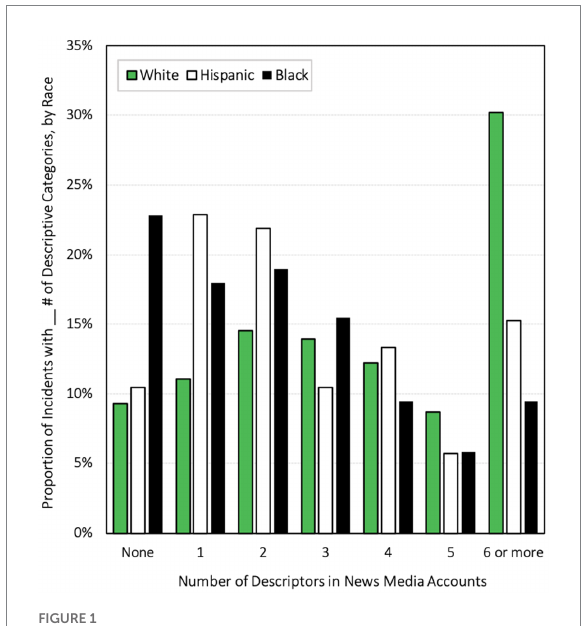
FIGURE 1 Average frequencies of descriptive categories in news media accounts of mass shootings by race,